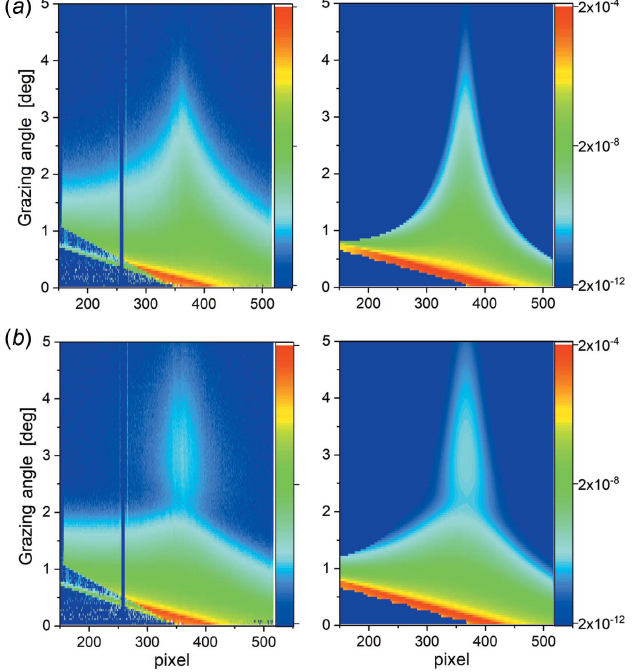
Figure 7 ( a ) 2D map of liquid copper measurement (left) and the corresponding calculation (right) with the curvature radius R = 215 mm; ( b ) 2D map of liquid copper with graphene: measurement (left) and corresponding calculation (right) with the curvature radius R = 115 mm.